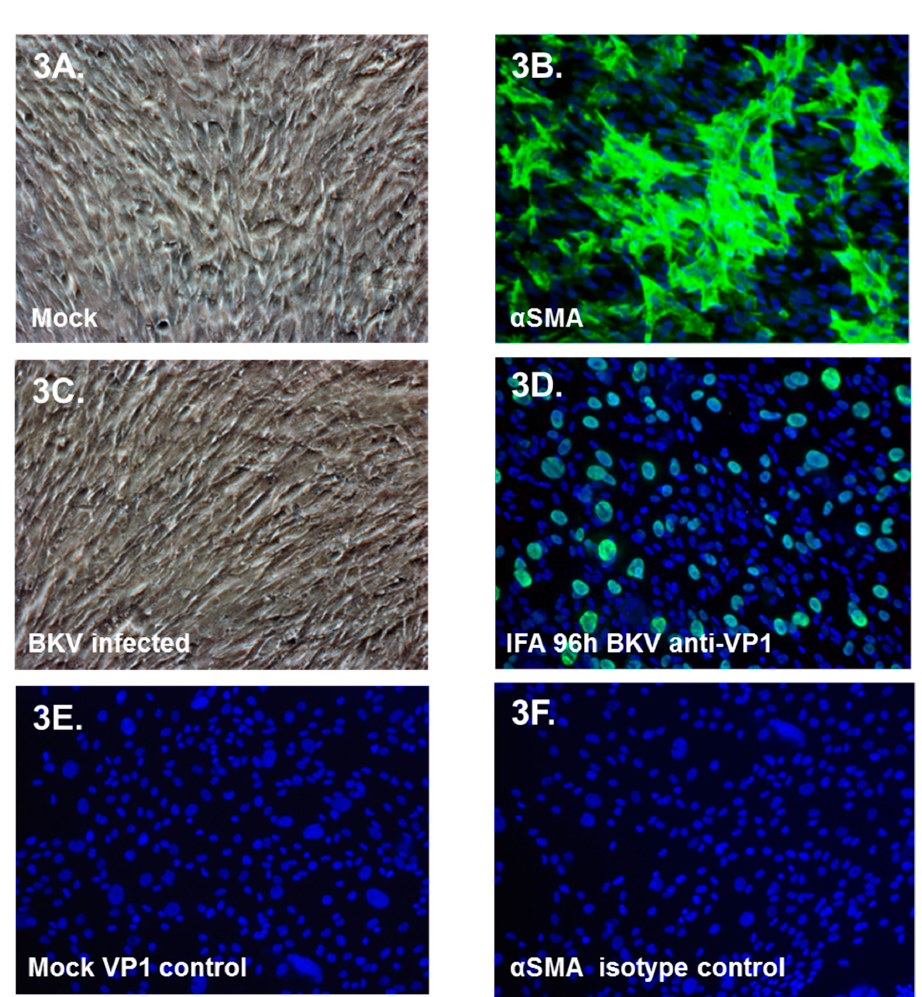
Figure 3. Immunofluorescence analysis of BKV replication in mesangial cells. ( A ), Phase-contrast image of mock-infected mesangial cells, ( B ) immunofluorescence staining of mock-infected mesangial cells stained with the α -smooth muscle actin ( α SMA) antibody, ( C ) Phase-contrast image of BKV-infected mesangial cells 96 h after infection ( D ), immunofluorescence staining of BKV-infected mesangial cells with the SV40 Large-T-antigen (SV40-LTAg) antibody 96 h post-infection ( E ), and mock-infected mesangial cells stained with the SV40-LTAg antibody. ( F ) mock-infected mesangial cells stained with the α SMA antibody. Nuclei were stained blue with DAPI. All images × 200